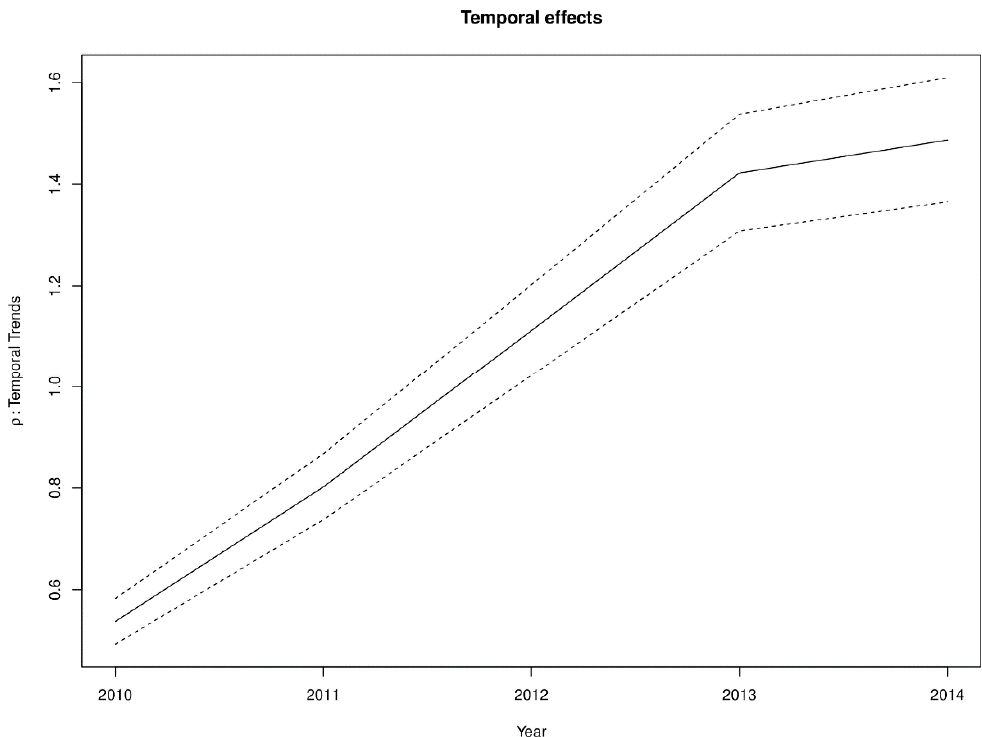
Figure 8. First-order random walk patterns of intestinal parasites risk from 2011–2014.